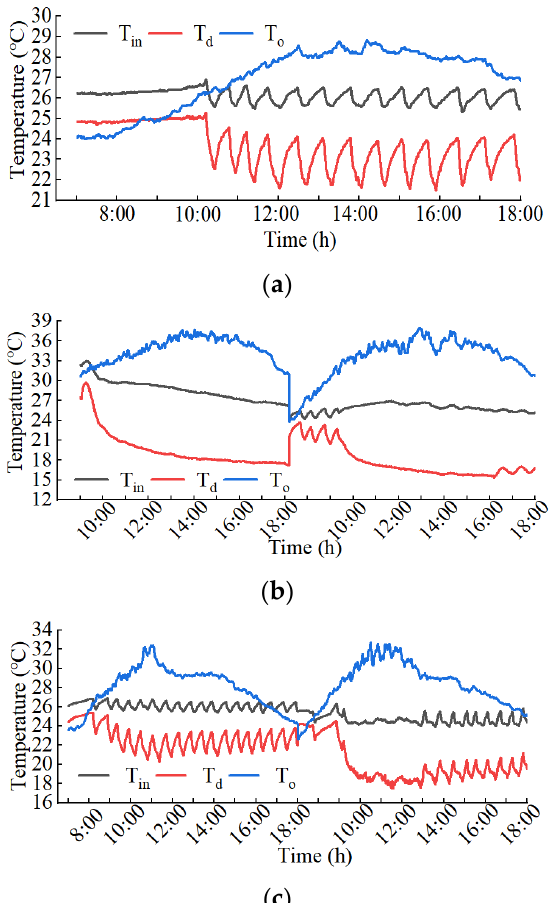
Figure 9. Temperature field showing ( a ) T in change on the LH, ( b ) T in change on the HL, and ( c ) T in change on the MM.